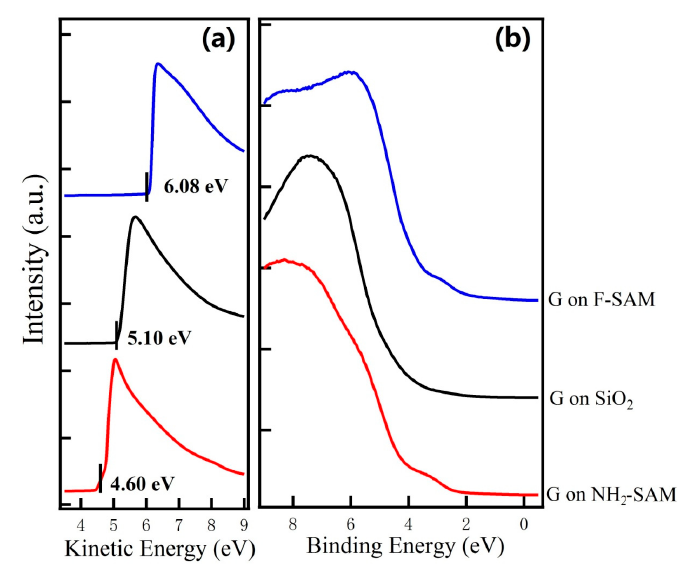
Figure 2. UPS spectra at the ( a ) low kinetic energy region and ( b ) low binding energy region for graphene on NH 2 -SAM, SiO 2 , and F-SAM.